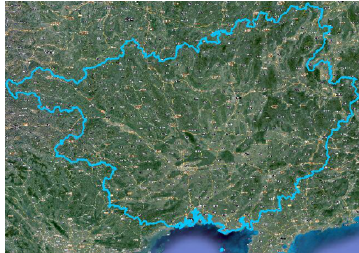
Figure 2. covers the rectangular area with the minimum and maximum longitude and latitude in the western region